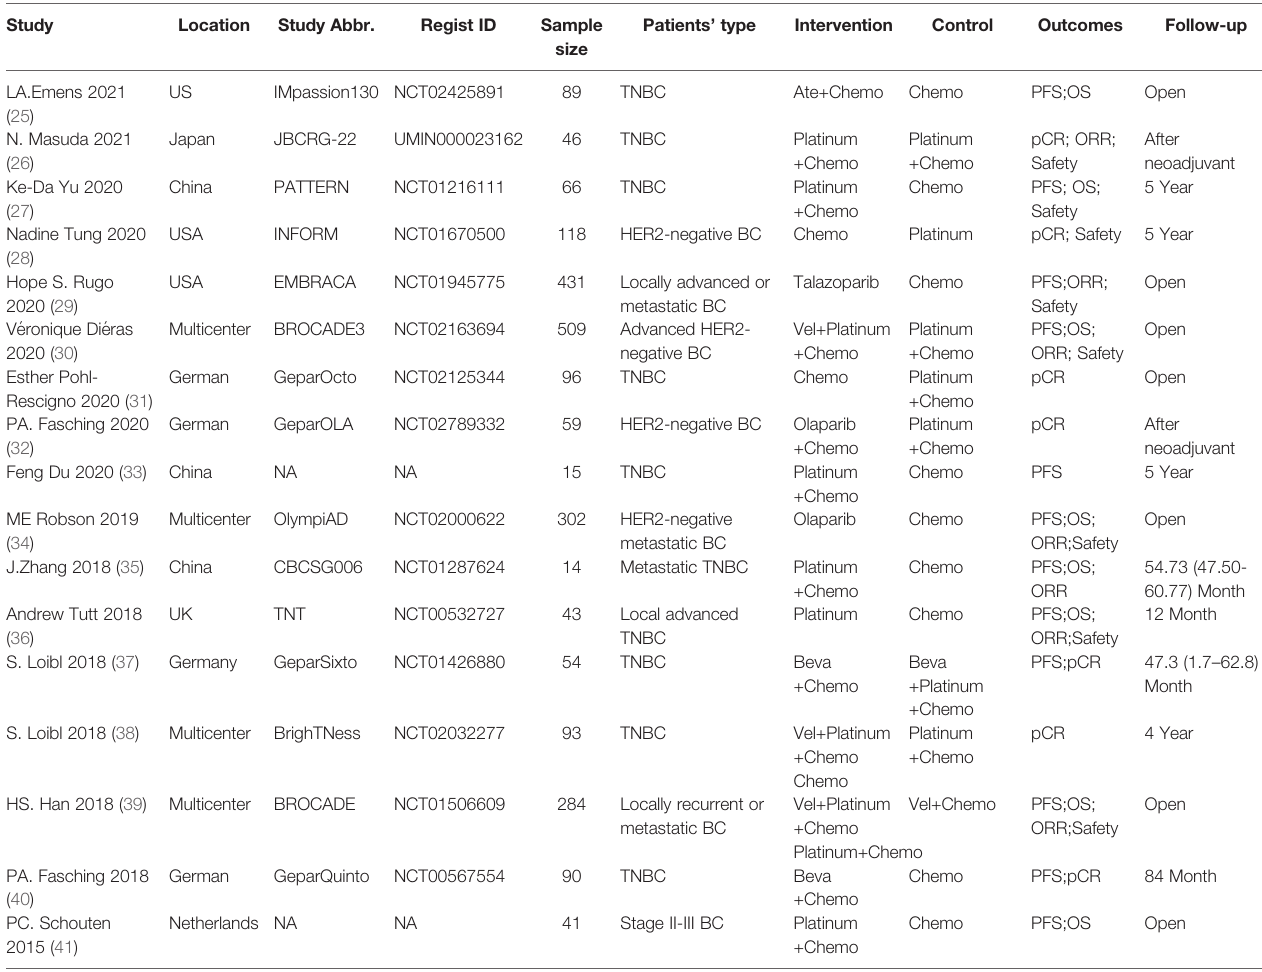
TABLE 1 | Characteristics of the included